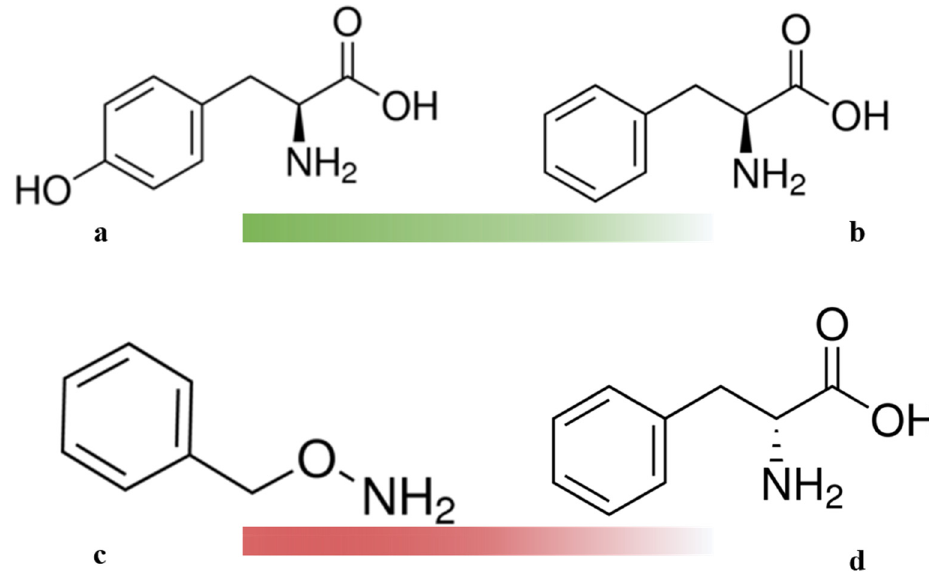
Figure 5. Active compounds used in the experiment: substrates L-Tyrosine ( a ) and L-Phenylalanine ( b ); inhibitors O-Benzylhydroxylamine ( c ) and D-Phenylalanine ( d ).